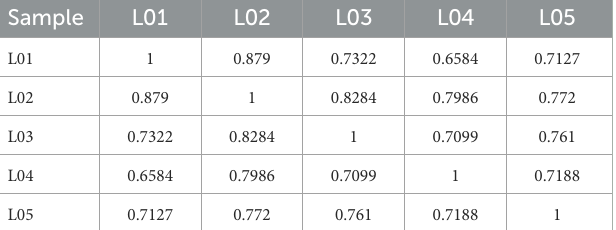
TABLE 5 Statistical table of biological replicate correlation. TABLE 6 Statistics of circRNA number.